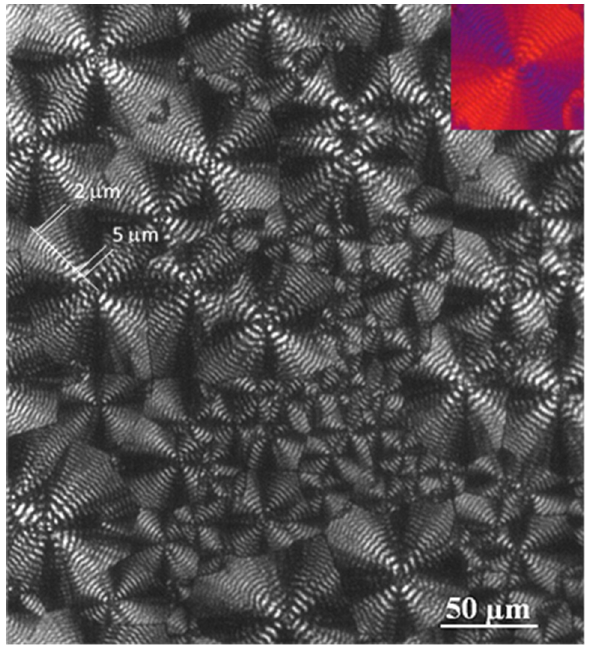
Figure 5. Optical micrograph at the end of the non-isothermal crystallization (0.5 °C/min) of P4HB. The decrease in the interring spacing during crystallization is evident. Inset shows a micrograph taken with a first-order red tint plate to determine the birefringence sign.